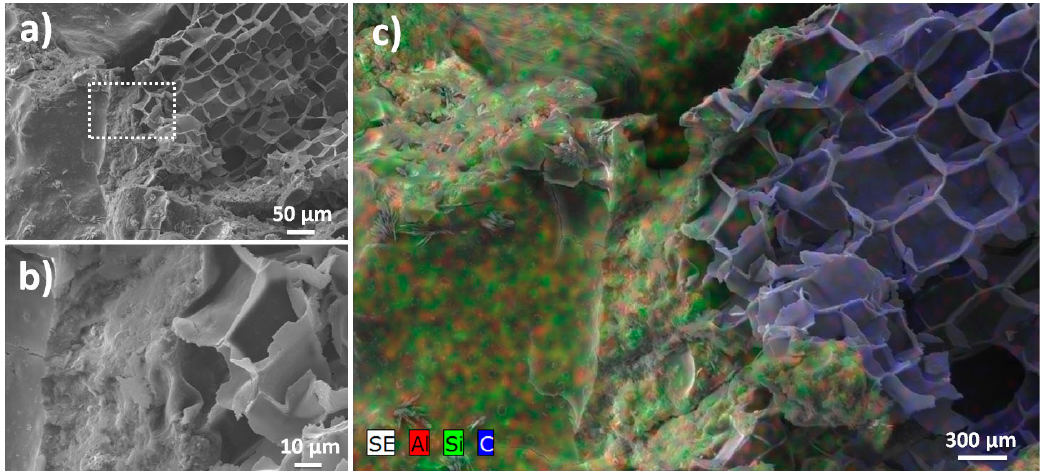
Figure 5. SEM micrograph at two magnifications ( a , b ) and corresponding EDS elemental mapping ( c ) for the cork-foam prepared with 0.10 wt.% Al.